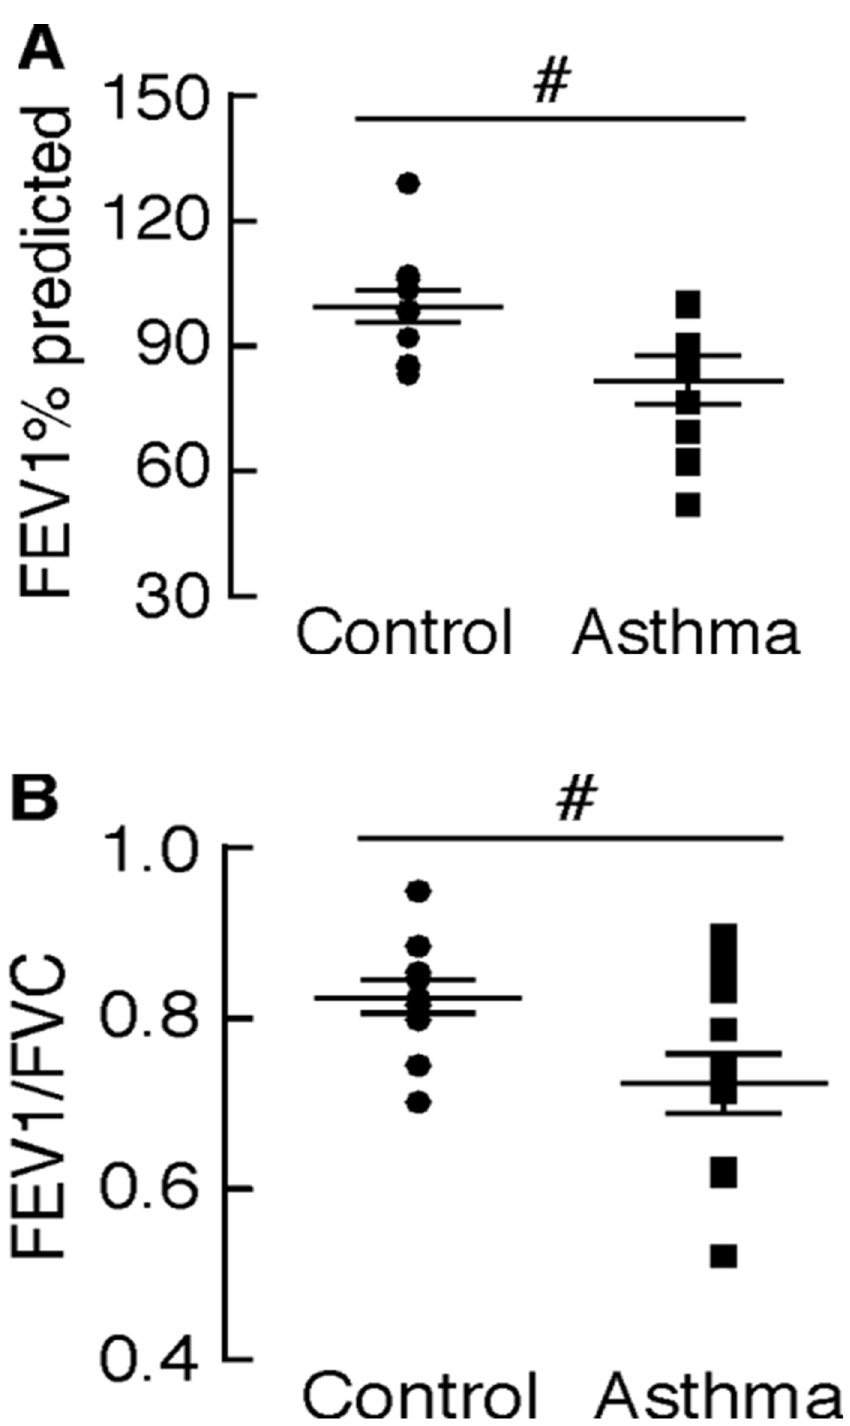
Fig 1. Asthmatics show airflow obstruction compared to healthy controls. Airflow obstruction as measured by (A) FEV1% predicted and (B) FEV1/FVC in asthmatic individuals compared with healthy control subjects. #p <